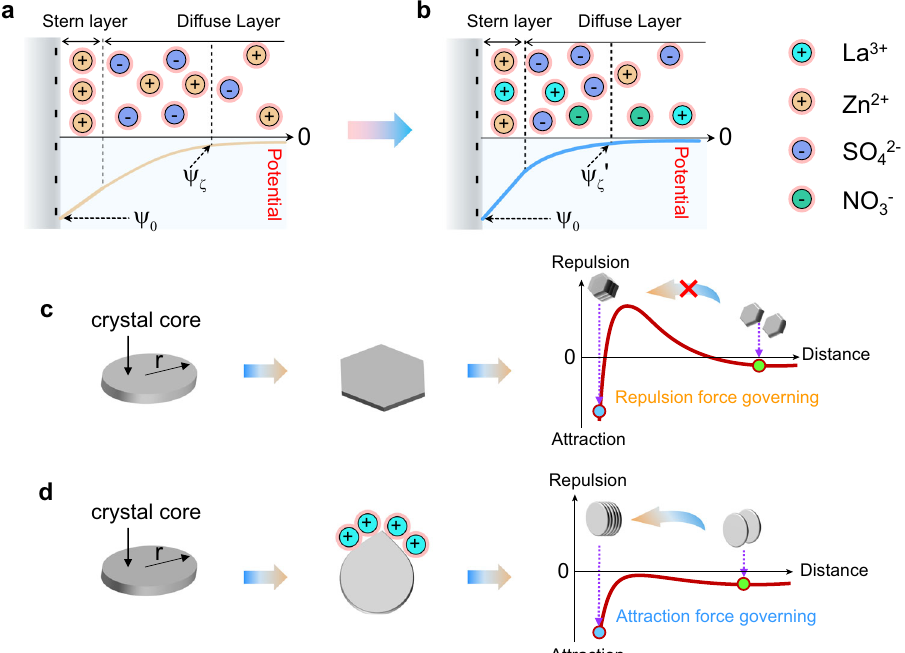
Fig. 4 The illustrations of the coherent electrodeposition induced by a compressed electric double layer of Zn particles. The comparison of the electric double layer of the Zn deposits in ( a ) ZS and ( b ) La 3 + -ZS electrolytes; the as-proposed growth models of the Zn deposits in ( c ) ZS and ( d ) La 3 + -ZS